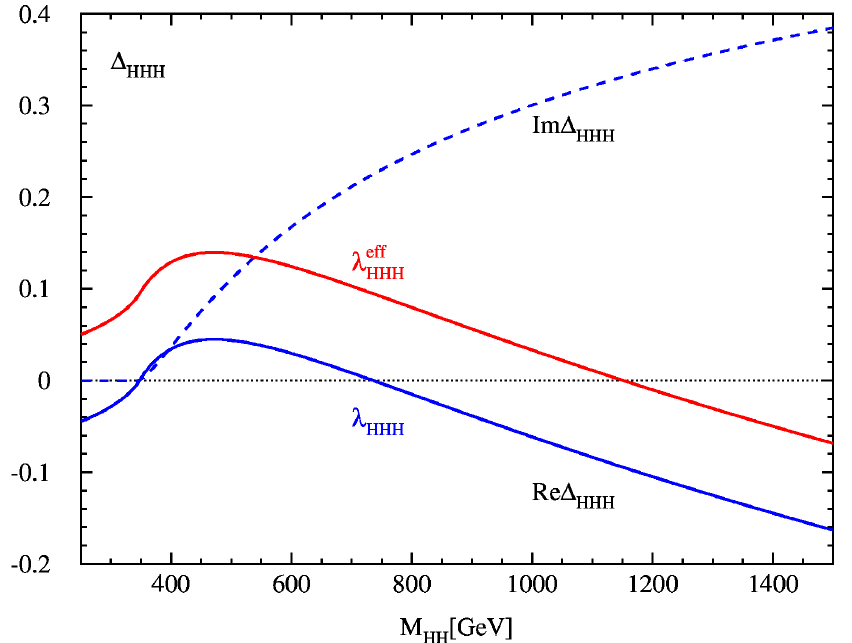
Figure 4 . The relative top-Yukawa-induced electroweak correction factor ∆ HHH as a function of the invariant Higgs-pair mass M HH . The full blue curve shows the real part of ∆ HHH and the dashed blue on the imaginary part. The red curve exhibits the real part after introducing the effective trilinear coupling λ eff HHH of eq. (3.11) and adding the shift of eq. (4.6). To guide the eye the dotted black curve has been added as the